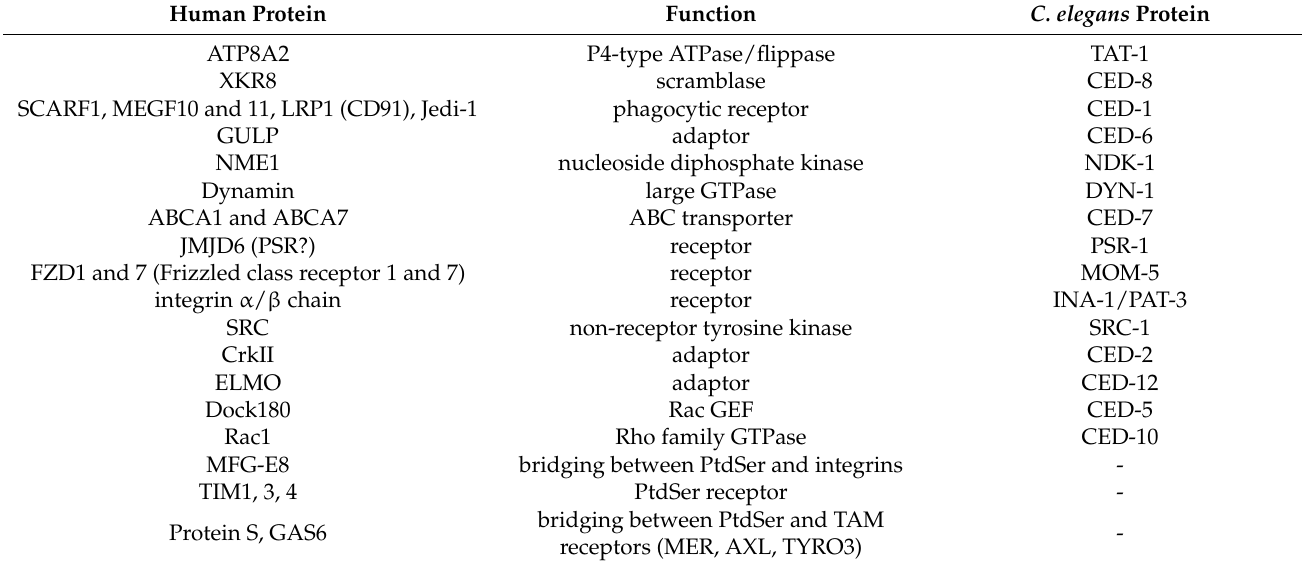
Table 2. Molecules involved in the phagocytosis of apoptotic cells in human and C. elegans . Human